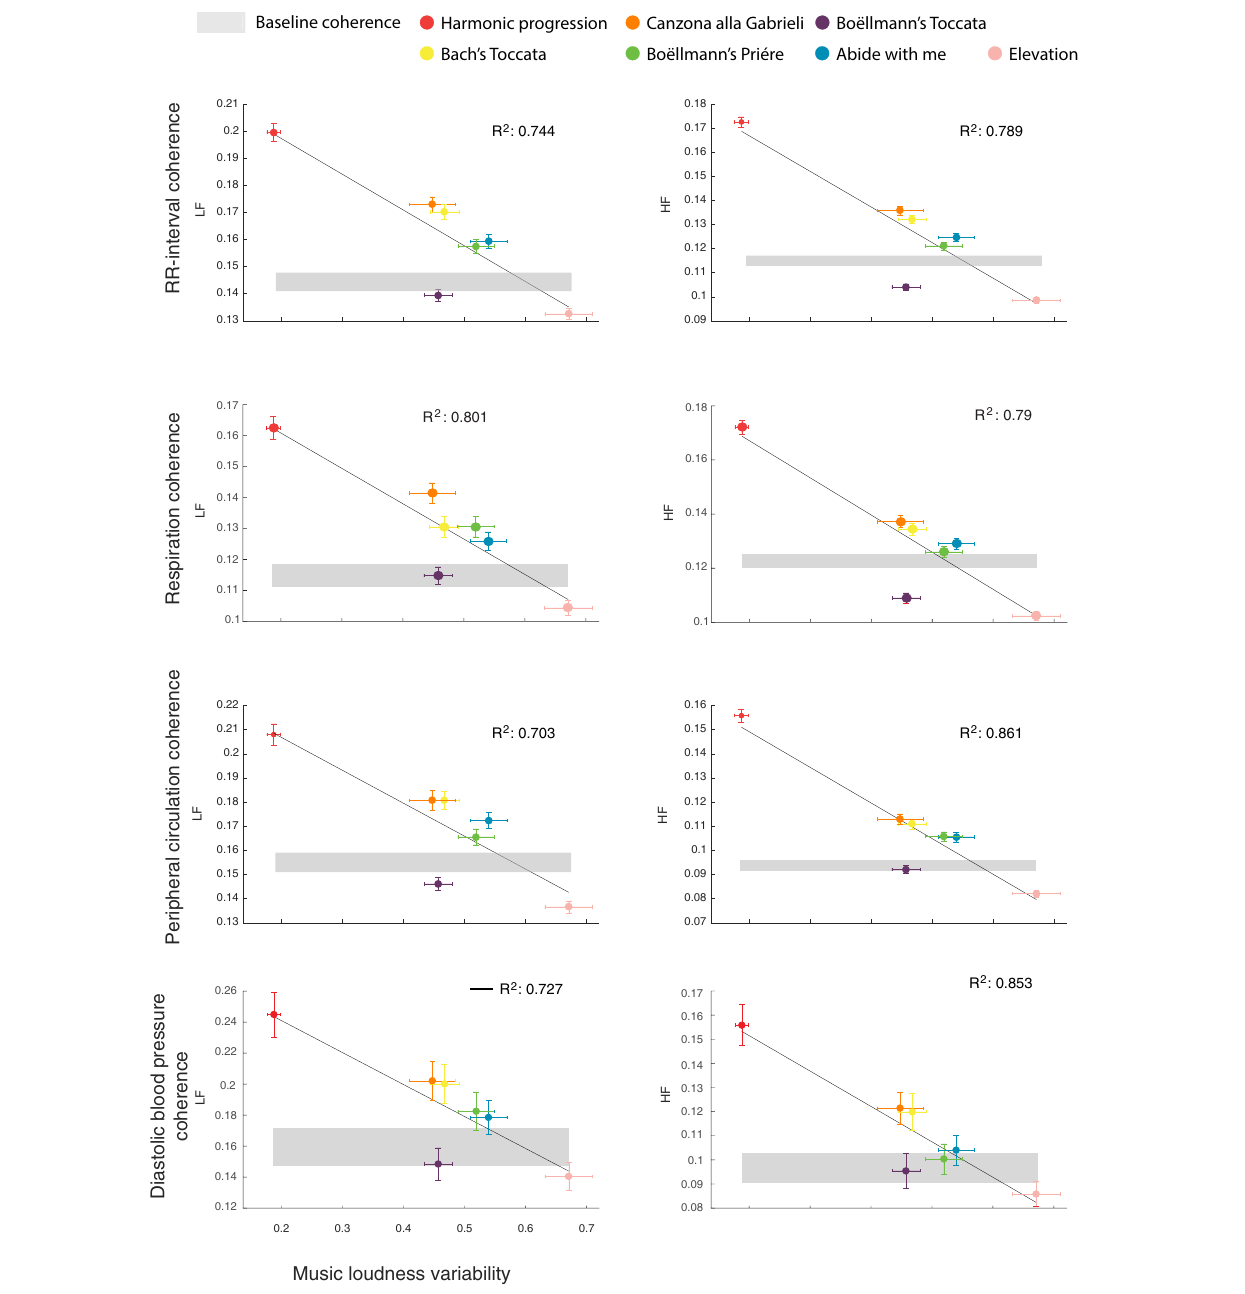
FIGURE 2 | Changes in group synchronization heavily depend on low-level auditory feature. Each dot represents one of the seven music excerpts, plotted as a function of group synchronization (y axis), averaged across musicians and non-musicians, and loudness variability index (x axis). Vertical error bars represent variability in synchronization across different individuals and days. Horizontal error bars represent variability in the loudness variability index across different performances of the same excerpt. The shaded gray area represents the average group synchronization during the initial resting baseline (mean ± SE). Dots below and above the gray shaded area indicate decreased and increased group synchronization compared to baseline, respectively, (see Table 2 for a statistical account of the comparison with baseline). It can be seen that greater autonomic synchronization is achieved for music excerpts with lower loudness variability